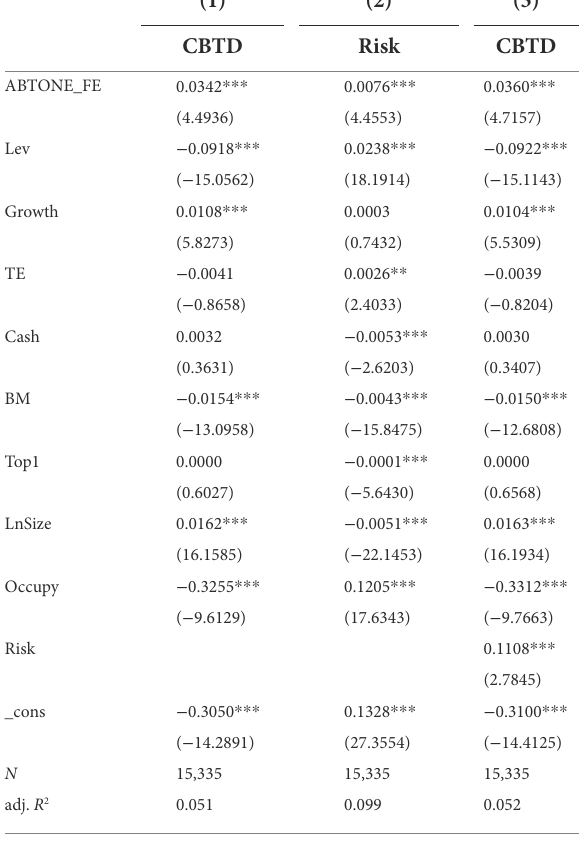
TABLE 6 Mediating effect after replacement of explanatory variables. TABLE 7 Mediating effect test after replacement of the explained